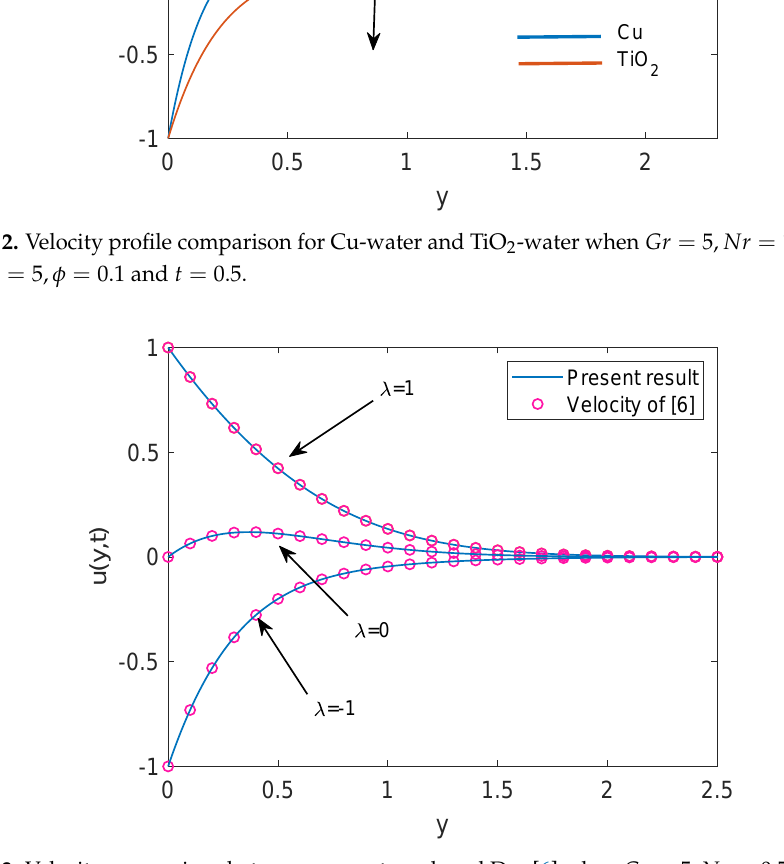
Figure 3. Velocity comparison between present work and Das [6] when Gr = 5, Nr = 0.5, K = 100, Q = 0, M 2 = 5, φ = 0.1 and t =